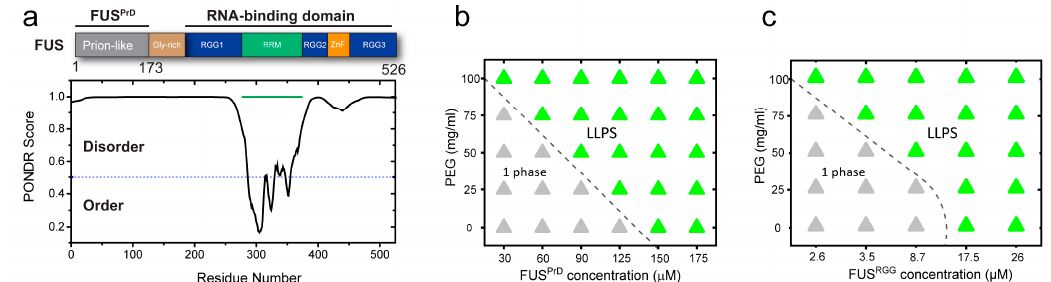
Figure 3. FUS FL harbors distinct low-complexity disordered domains (LCDs) that individually undergo crowding-mediated liquid–liquid phase separation (LLPS). ( a ) Domain architecture of FUS; two distinct disordered domains are highlighted. The N-terminal FUS LCD has prion-like sequence features (FUS PrD ) and C-terminal LCD is enriched in RGG-repeats (FUS RGG ). The disorder prediction scores (using VSL2 algorithm [60]) are also shown in the bottom panel. ( b , c ) Effect of PEG on the LLPS of prion-like LCD and arginine-rich polycationic LCD (R-rich LCD). Shown here are the phase diagrams of FUS PrD and FUS RGG with PEG8000, respectively. The dotted lines indicate the liquid–liquid coexistence boundaries.